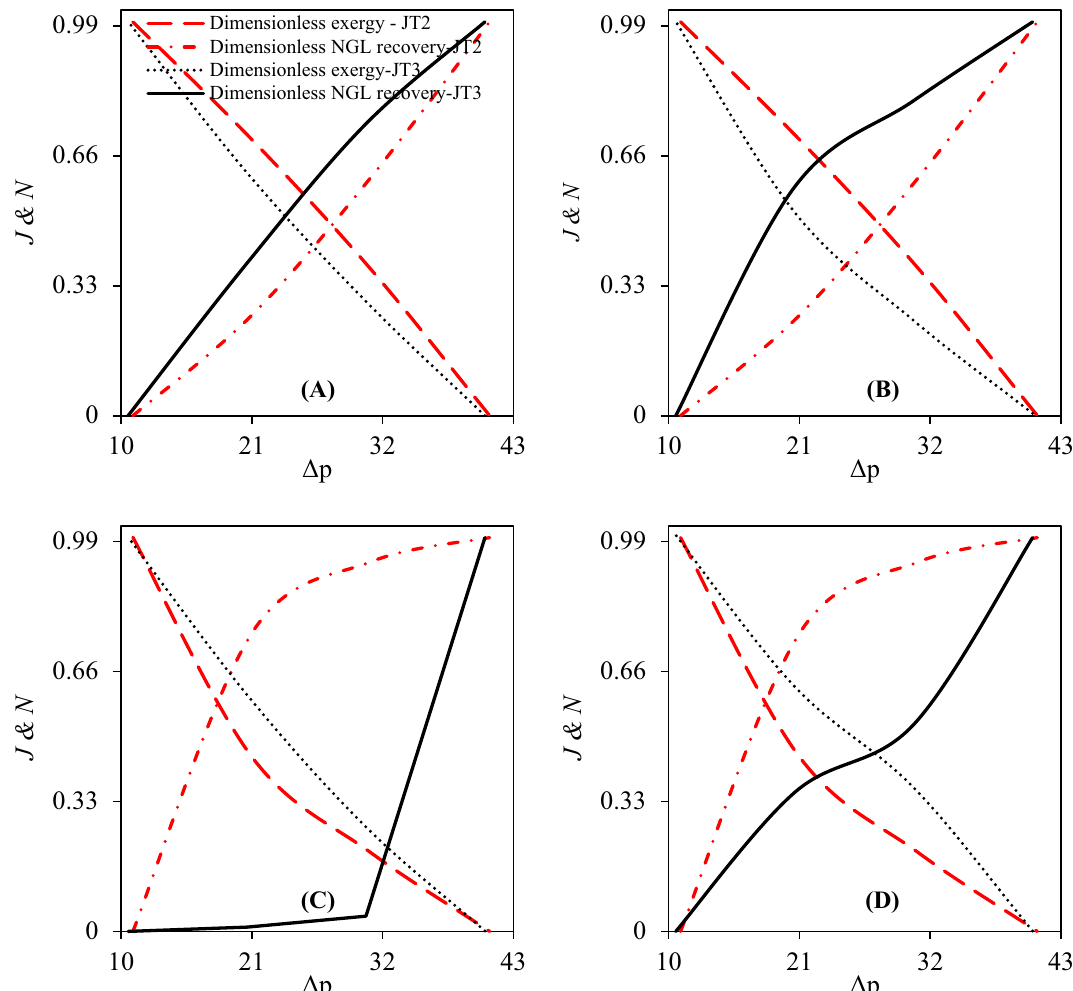
Figure 17. Optimization of investigated gas plant based on the dimensionless exergy efficiency and NGL recovery rate: ( A–D ) correspond to configurations ( A–D )